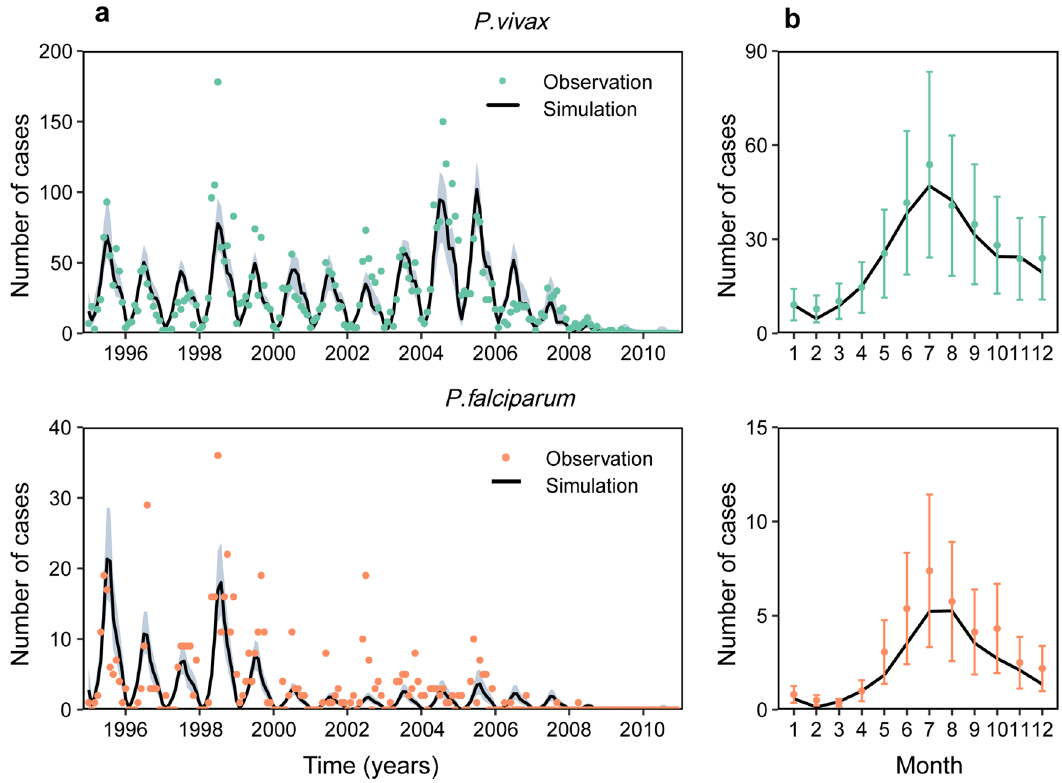
Fig. 2 Mathematical model simulations of clinical malaria cases. a The time series of number of clinical cases. b The seasonal pattern of number of clinical cases. Observations are shown as points (number of reported malaria cases). The solid lines correspond to the simulations, and the dark grey indicates the 95% credible intervals. We only present the fi nal results, focusing on the median of posterior distributions and 95% credible intervals extracted from 10,000 runs. Seasonal pattern for the observed cases (points and error bars represent average monthly cases and the 95% con fi dence interval, respectively) and the median of model simulations (black line). Table 2 Comparison of the dynamic models including the seasonal component, climatic component, vector control, and prevention of transmission of observed malaria epidemics.